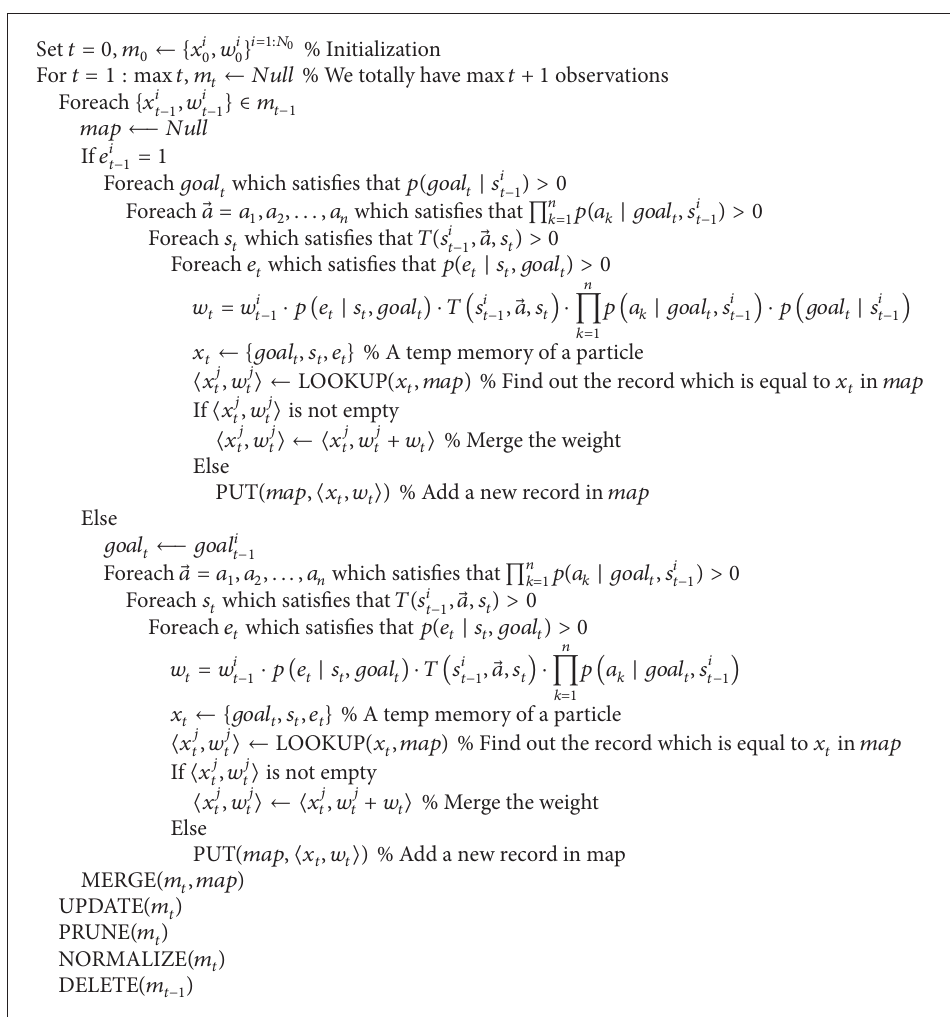
Algorithm 1: Goal inference based on the marginal filter under the framework of